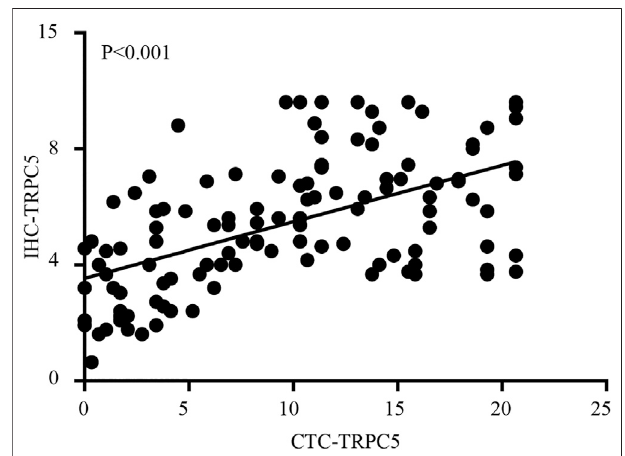
FIGURE 2 | The Pearson correlation analysis signi fi cant relationship between CTC-TRPC5 and IHC-TRPC5